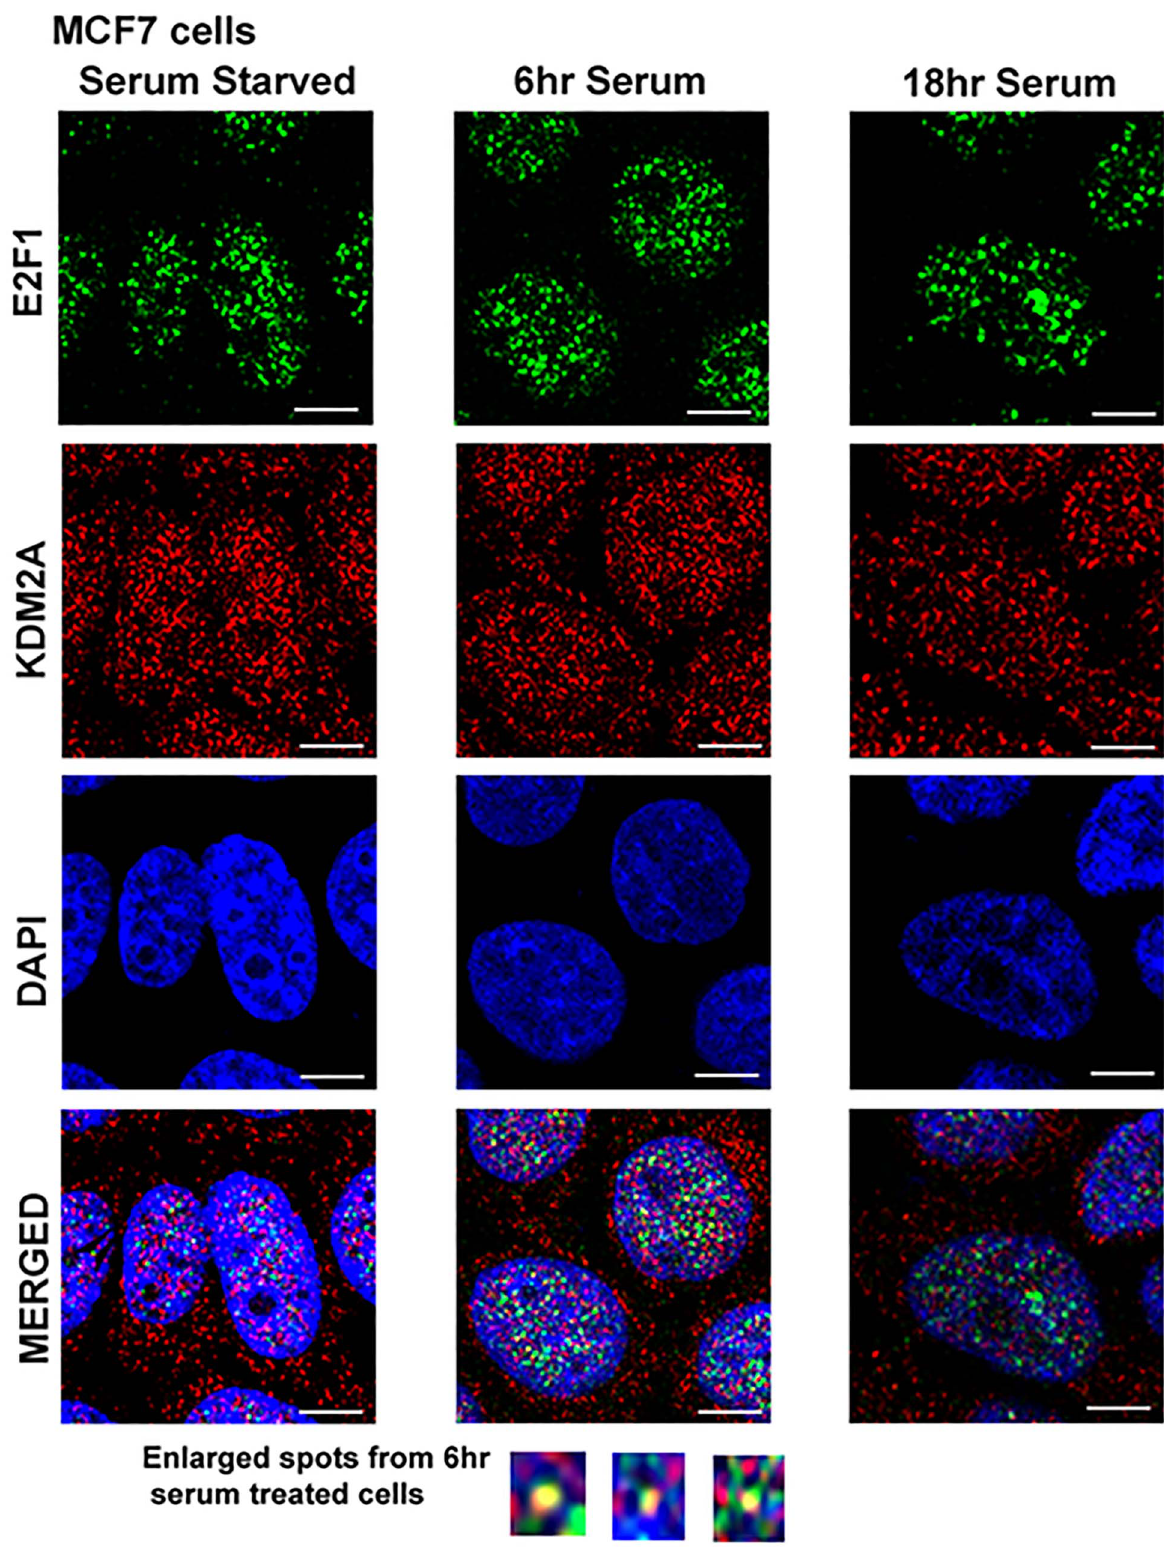
Figure 4. KDM2A co-localizes with E2F1 at 6 hr of serum stimulation. Quiescent MCF-7 cells were serum starved for 48 hr and serum stimulated for 6 hr and 18 hr. Cells were fixed, permeabilized for 5 min with 0.2% Triton X-100/PBS and immunostained for E2F1 (anti-mouse IgG, green) and KDM2A (anti-rabbit IgG, red). Cells were visualized by confocal microscopy. E2F1 was predominantly localized in the nucleus (upper panels), while KDM2A was more ubiquitously distributed in the cells (middle panels). Co-localization of E2F1 and KDM2A was observed in the nucleus at 6 hr of serum stimulation and disappeared totally by 18 hr (right panels). Images were captured at 630X oil using DM16000 inverted Leica TCS SP5